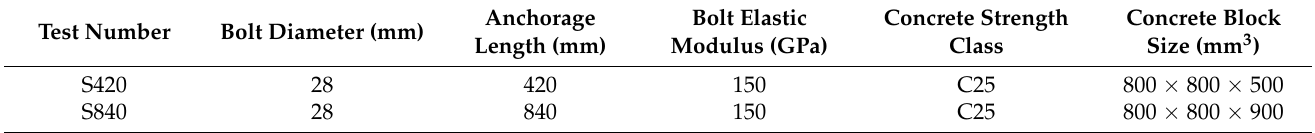
Table 1. Test material